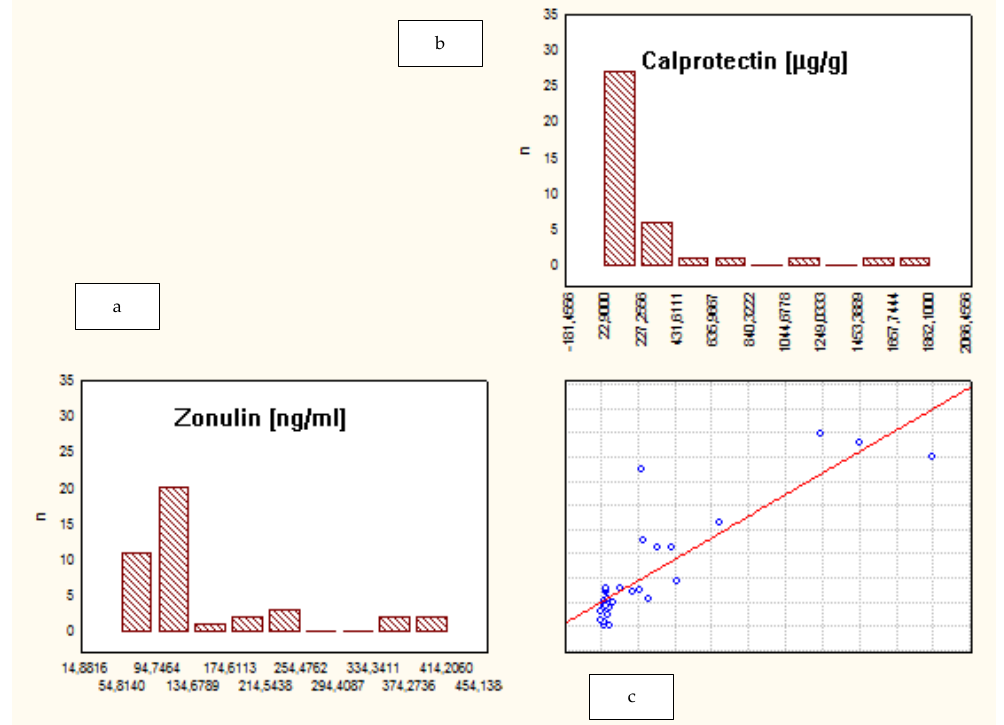
Figure 3. Correlation between fecal zonulin and calprotectin levels in patients with UC. ( a ) Levels of fecal zonulin in patients with UC; ( b ) levels of fecal calprotectin in patients with UC; ( c ) the correlation between levels of fecal zonulin and calprotectin in patients with UC.